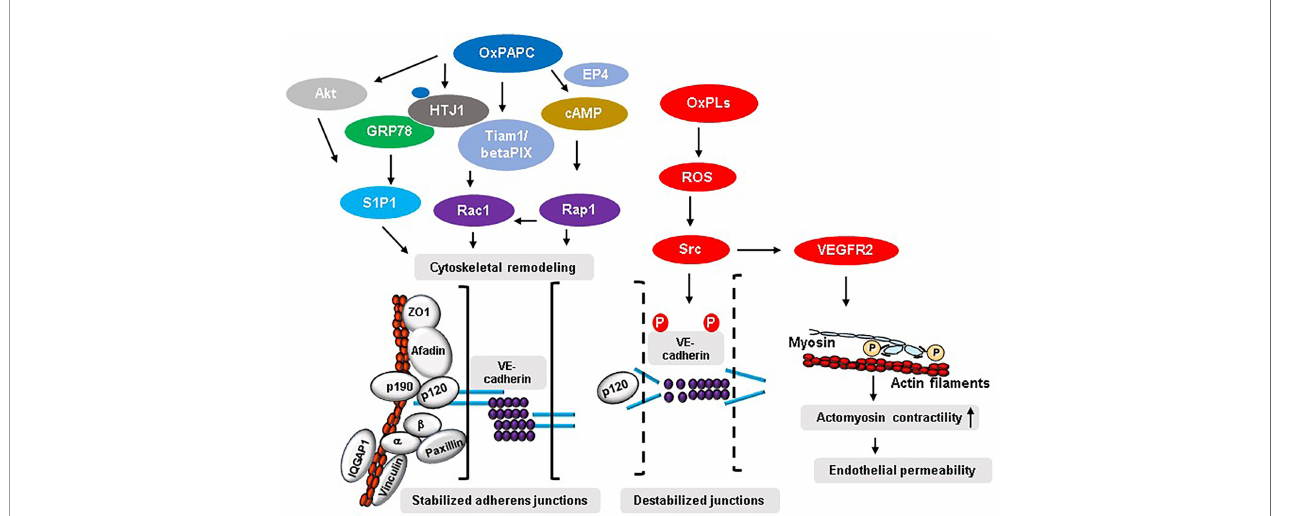
FIGURE 2 | Mechanisms of OxPLs-mediated regulation of endothelial barrier. OxPAPC-induced activation of S1P1 in Akt or GRP78-dependent manner leads to an increased interaction between various AJ, TJ, and FA proteins resulting in enhancement of endothelial barrier integrity. Similarly, OxPAPC-mediated activation of Rac1 and Rap1 induces cytoskeletal reorganization favoring stabilized junctional assembly. On the other hand, truncated OxPLs-stimulated EC produce ROS that activates Src which phosphorylates tyrosine residues in VE-cadherin causing its internalization, degradation, and ultimately leading to disrupted endothelial barrier. Src also activates VEGFR2 that induces endothelial permeability via enhanced actomyosin contractility caused by increased myosin light chain